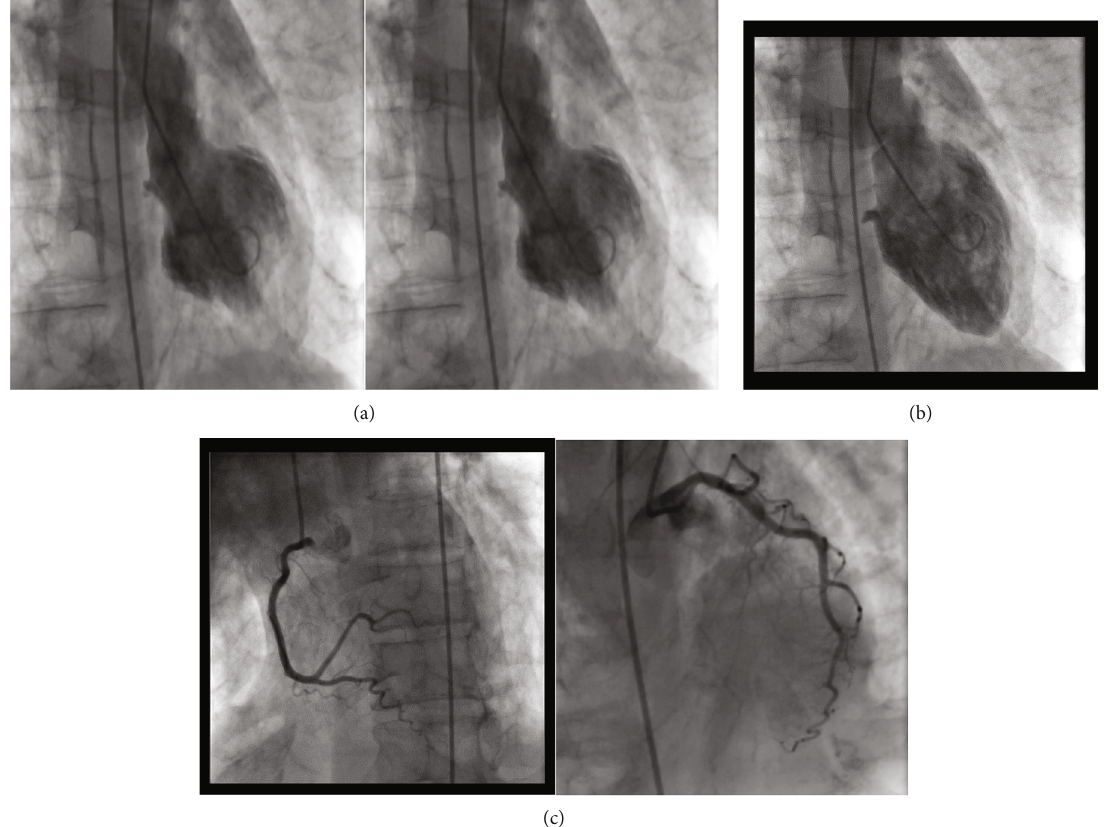
Figure 3: (a) Ventriculography of the left ventricle in systole showing basal and midventricular hypokinesis. (b) Ventriculography of the left ventricle in diastole. (c) Coronary angiography showing normal